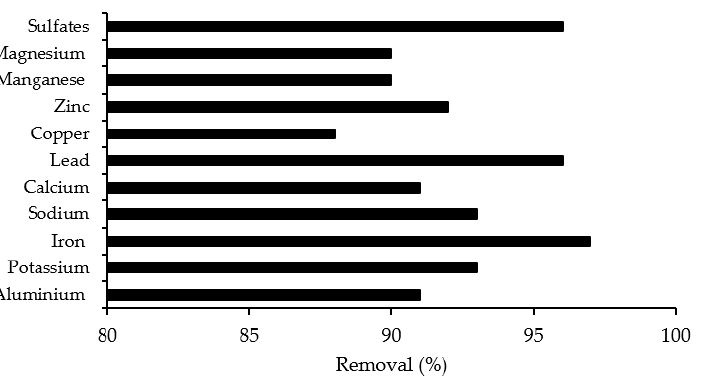
Figure 11. The average percent removal for pollutants, specifically in the FBR, over the treatment